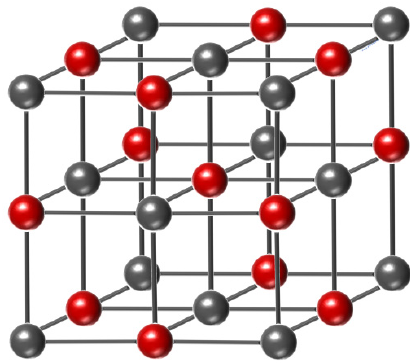
Figure 6. Crystal structure of nickel oxide.